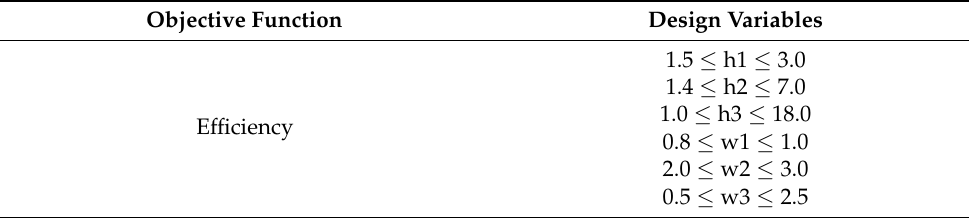
Figure 6. Parametrization of Type 3-1 rotor slot.